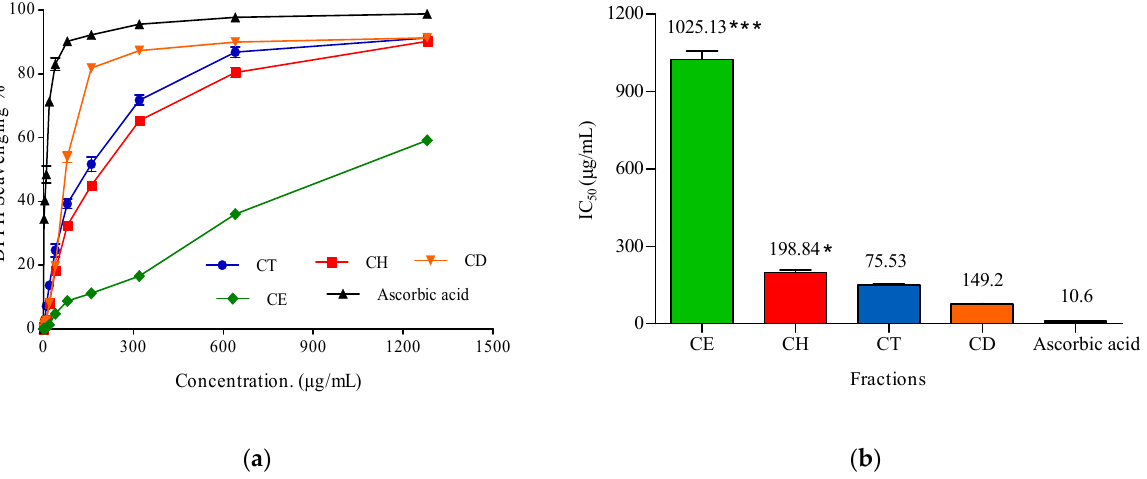
Figure 10. ( a ) 2,2-diphyenyl-picrylhydrazyl (DPPH) radical scavenging activity of different concen- trations (5–1280 µg/mL) of Cliona sp. Total extract (CT), Hexane (CH), Dichoromethane (CD), and Ethyle acetate (CE) fractions. ( b ) IC 50 of antioxidant activity of Cliona sp. total extract (CT), Hexane (CH), Dichloromethane (CD), and Ethyl acetate (CE) fractions and ascorbic acid (positive control). DPPH in methanol (without the tested sample) was used as a negative control. Data were analysed by using one-way ANOVA and statistical significance was calculated with Dunnett’s multiple com- parisons test, and the significance level compared to the control is indicated by asterisks (*, p < 0.05; ***, p < 0.0001). The data display the mean ±SD of three biological replicas.